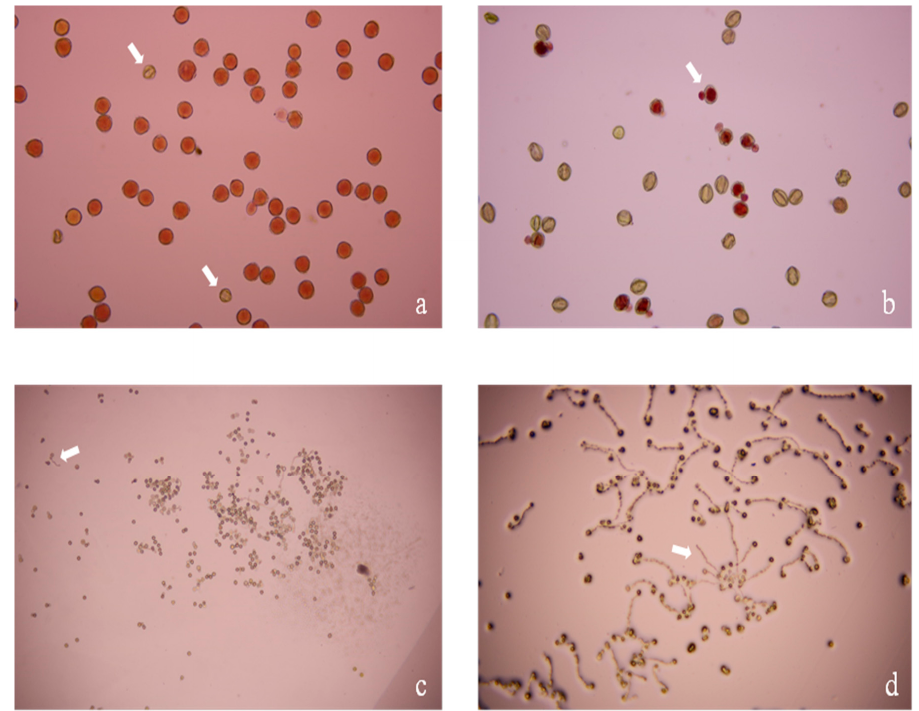
Figure 2. (a) Pollen grains stained with aceto-carmine (AC); (b) Pollen grains stained with 2, 3, 5-triphenyltetrazolium chloride (TTC). The arrow points to non-viable grains, (c) and (d) sprouted pollen grains on culture medium, directly on the plate. The arrow points to the pollen tube.